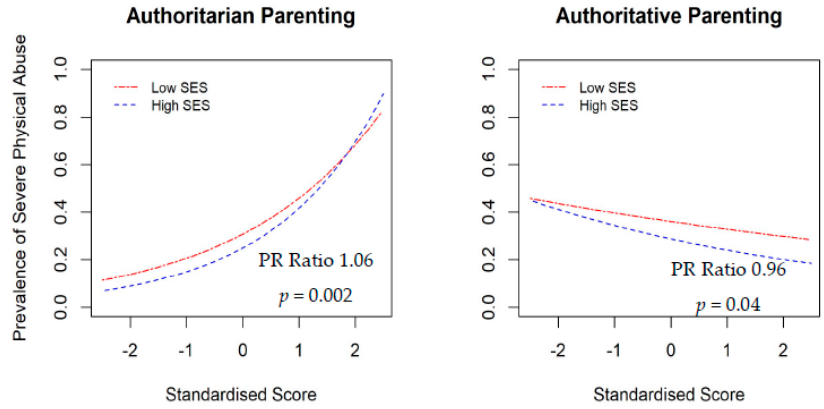
Figure 3. Moderation effect of family socioeconomic status on the association between parenting style and child maltreatment.